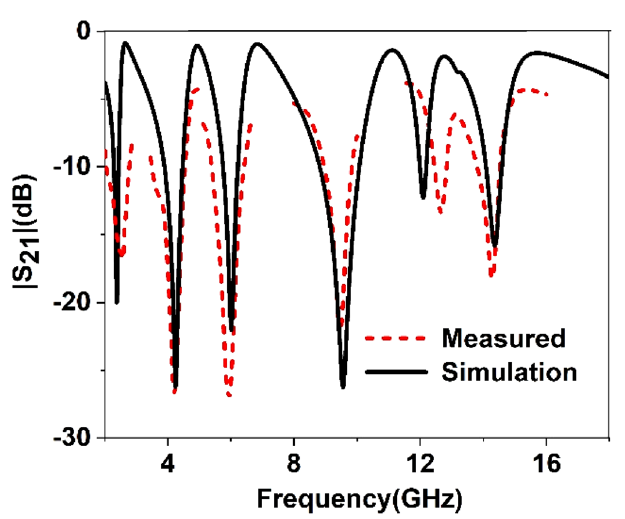
Figure 25. Simulated and measured S 21 for the unit